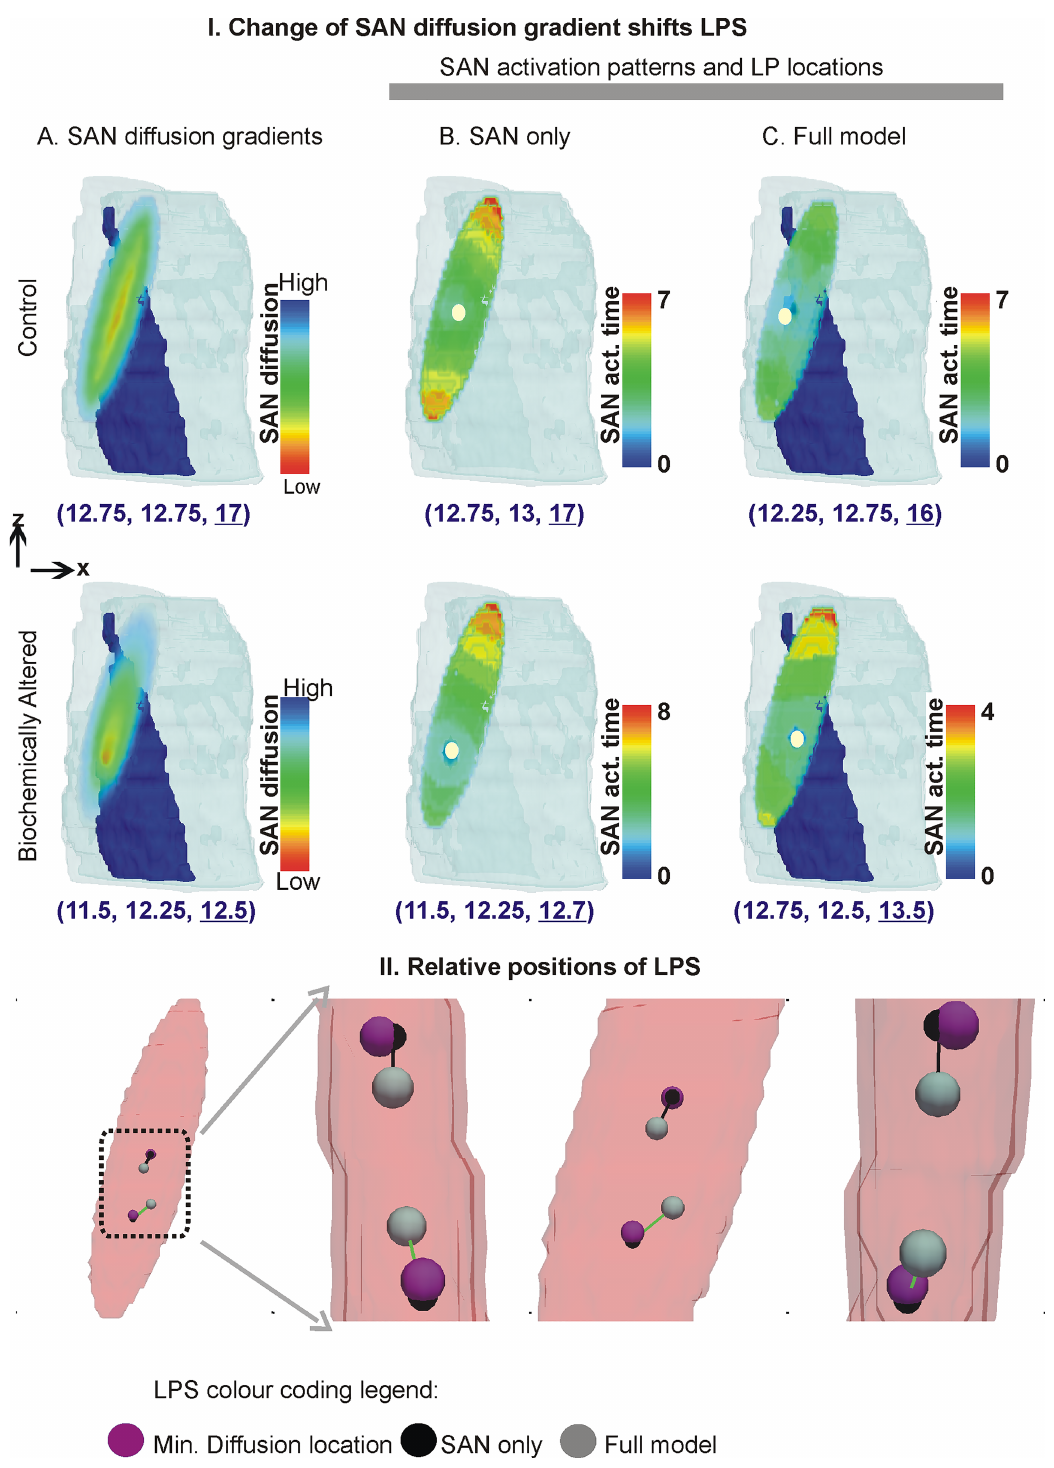
Fig 8. Shift of leading pacemakersite due to altered SAN micro-structure. I: Top row shows data for the control case (Fig 2) whilebottom row shows data for the altered SAN micro-structure case. A: model anatomies with colour coded SAN diffusion distribution. The locationof the lowest cell-cellcouplingis given, which lies within the SAN. B: LPS location in the SAN only case where border was omitted. C: LPS location in the full model case. In columns B and C, the white dots represent locationof the leadingpacemaker sites whilethe SAN activationtime is colour codedas denotedby